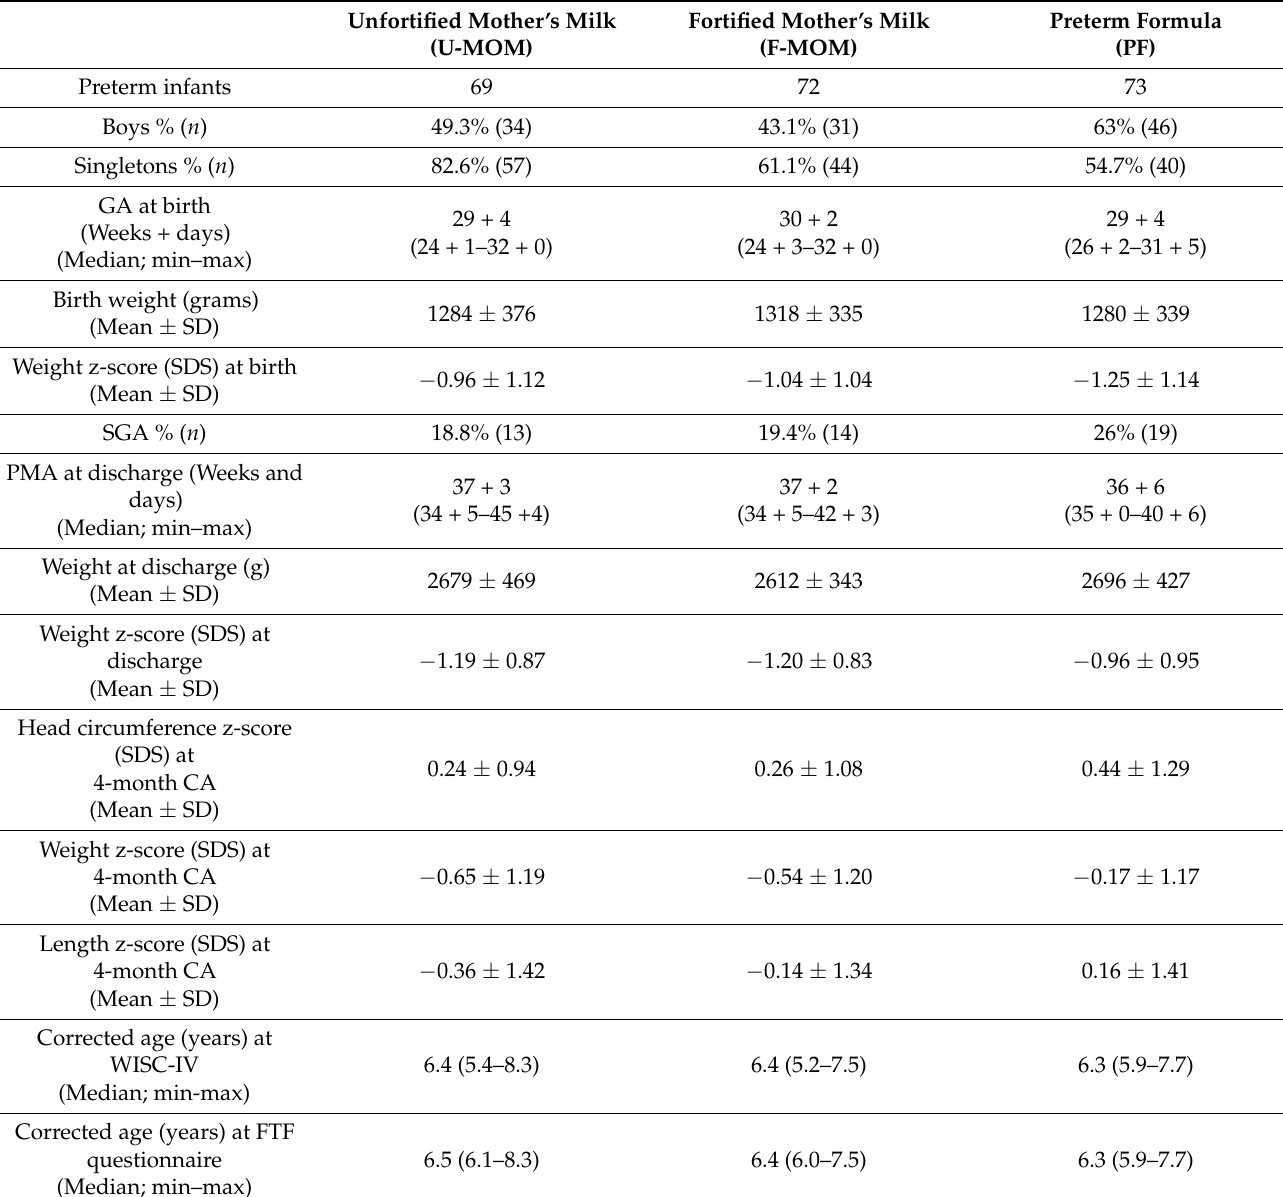
Table 1. Basic Characteristics of the study